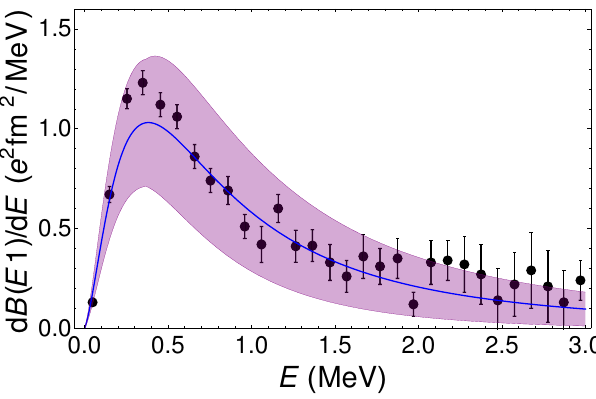
Figure 2. The dipole response spectrum for 11 Li after folding with the detector resolution (blue curve) with the theory error (purple band), and data from Ref.